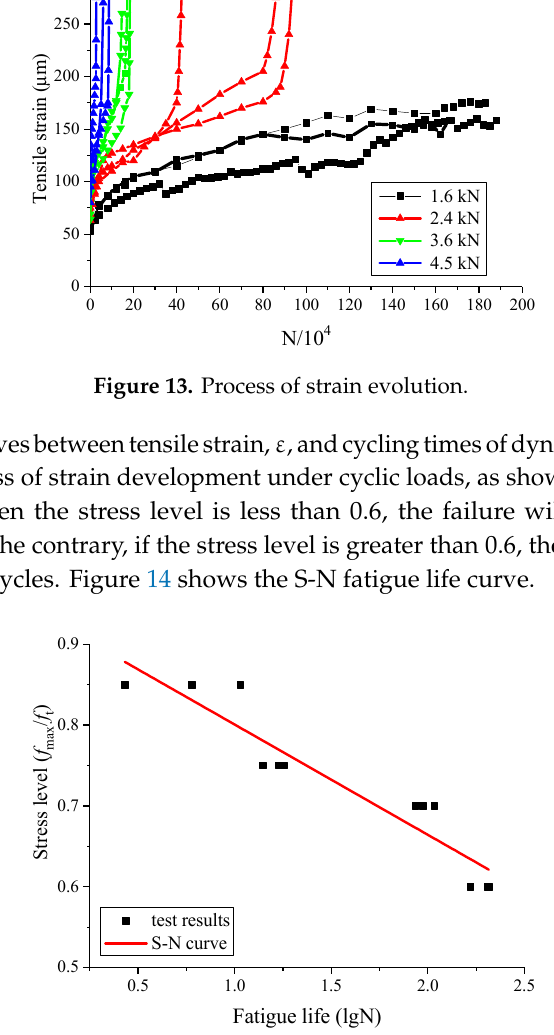
Figure 12. Strain evolutionary characteristics under different dynamic stress levels: ( a ) strain increment; ( b ) strain ratio.